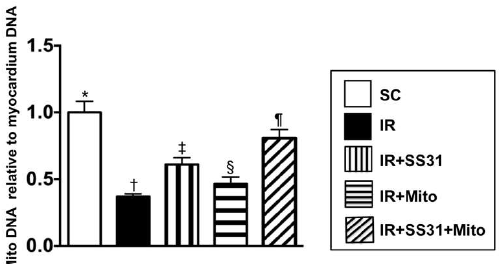
Figure 13. The relative mitochondrial DNA copy number to the left ventricular myocardium DNA copy number in the IR area Analytical result of mitochondrial DNA copy * vs. other groups with different symbols (†, ‡, §, ¶), p < 0.0001. All statistical analyses were performed by one-way ANOVA and followed by the Bonferroni multiple comparison post hoc test ( n = 8 for each group). Symbols (*, †, ‡, §, ¶) indicate significance at the 0.05 level. SC = sham control, IR = ischemia-reperfusion, and Mito =